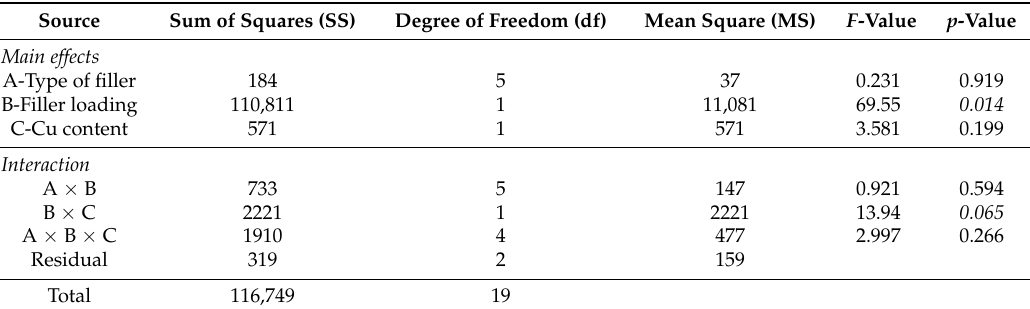
Table 6. ANOVA for parameter TS (N/mm 2